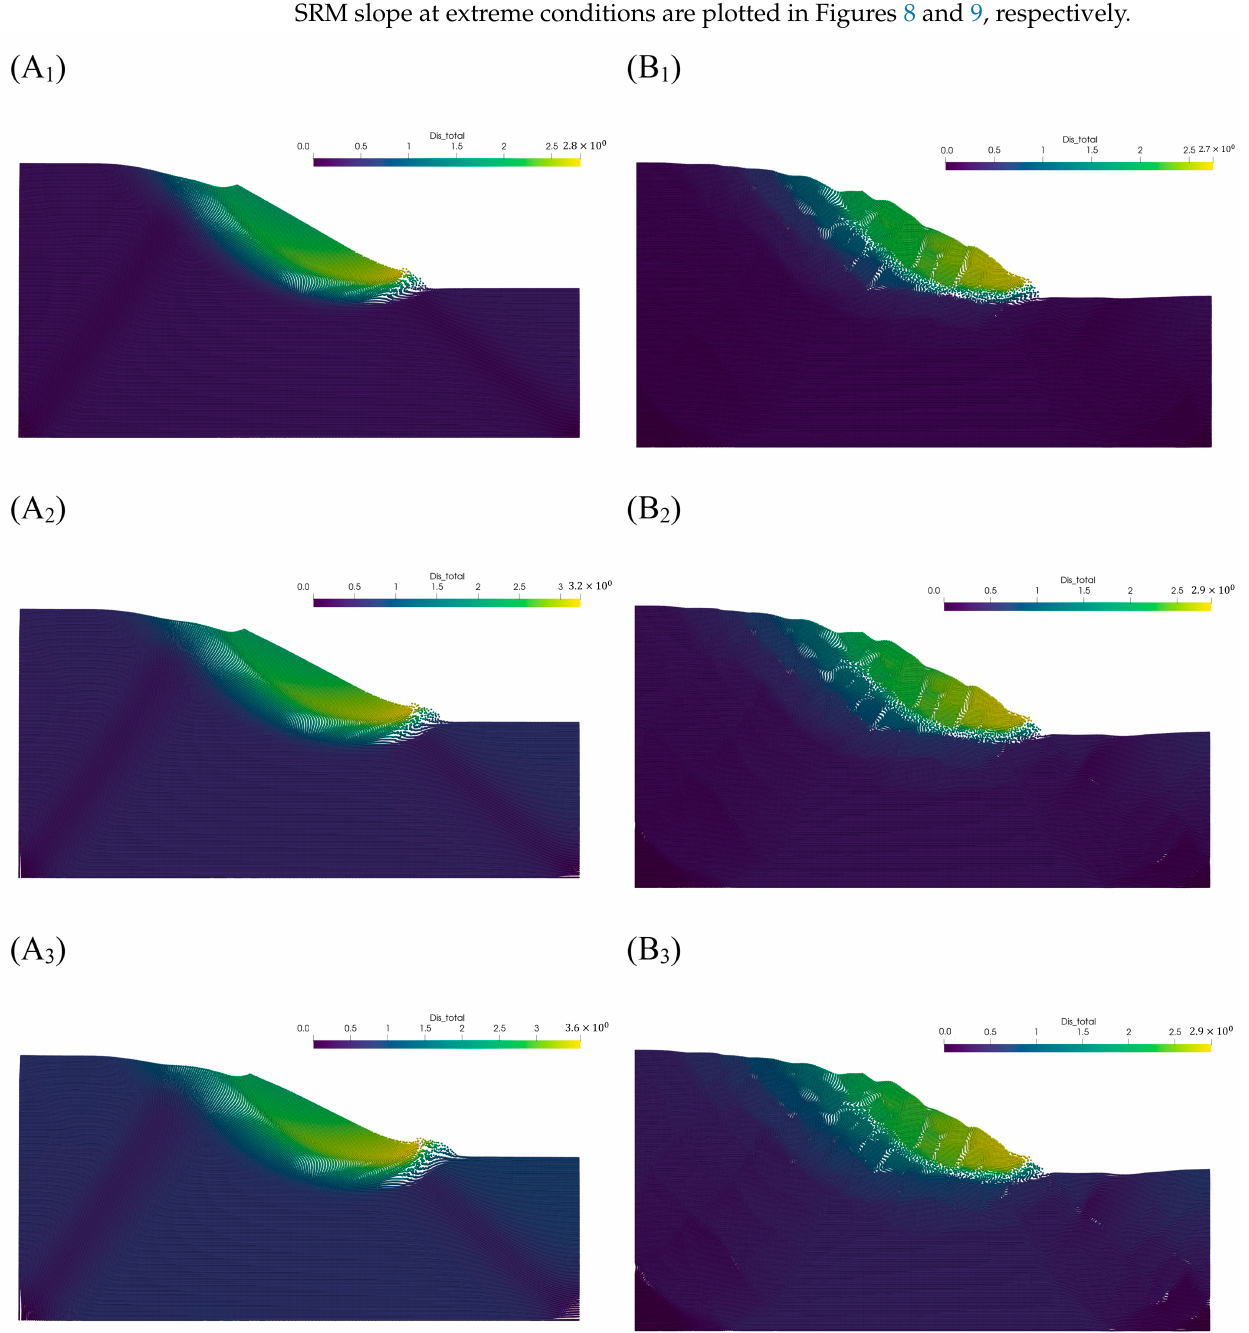
Figure 8. The displacement distribution clouds maps of the slopes at extreme conditions. ( A 1 – A 3 ) Displacement distribution of pure soil slopes at reduction factors equal to 1.8, 1.9, and 2.0, respec- tively. ( B 1 – B 3 ) Displacement distribution of SRM slopes at reduction factors equal to 2.3, 2.4, and 2.5,